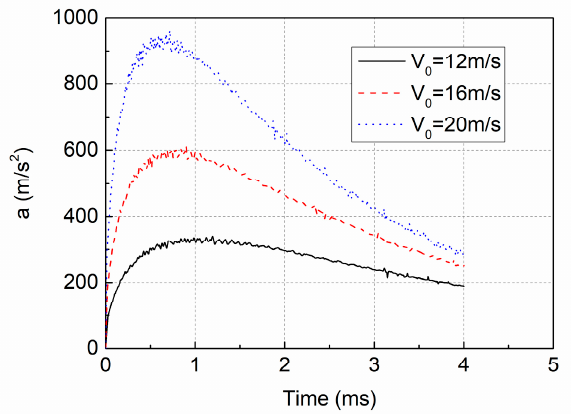
ff erent impact